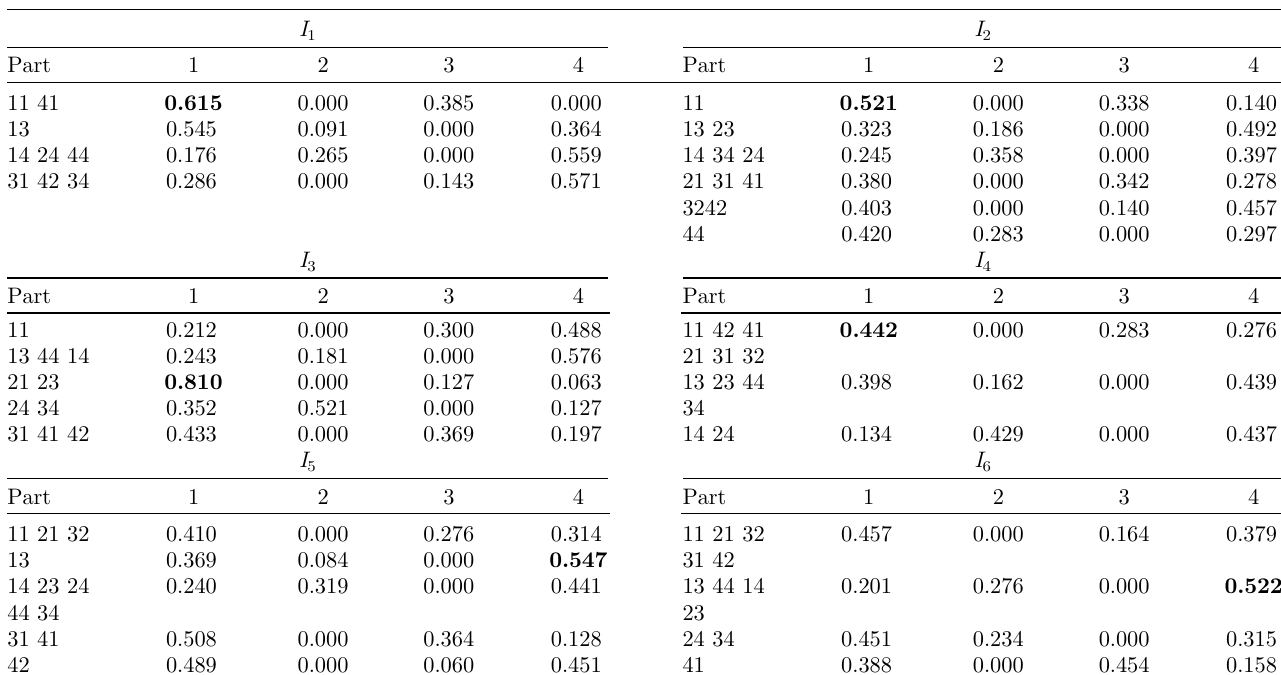
Table 6. PMM for the irregular clusters I i , i = 1, .. . , 6 see equation (4) and Remark 1. In bold type the highest probability for the